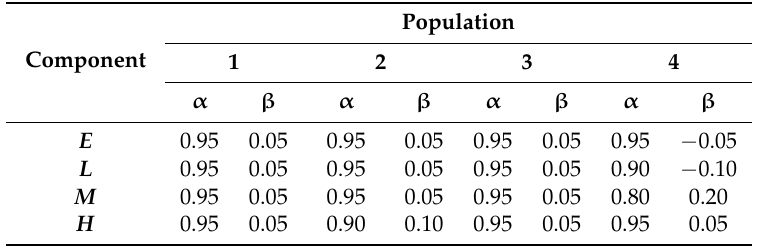
Table 1. The parameters ( α and β ) of Equation (2) used to simulate each population of entry ( E ), live growth ( L ), mortality ( M ) and harvest ( H ). (The increase in mortality, by a factor of four, for Population 3 in 2004 is not represented in the table.)